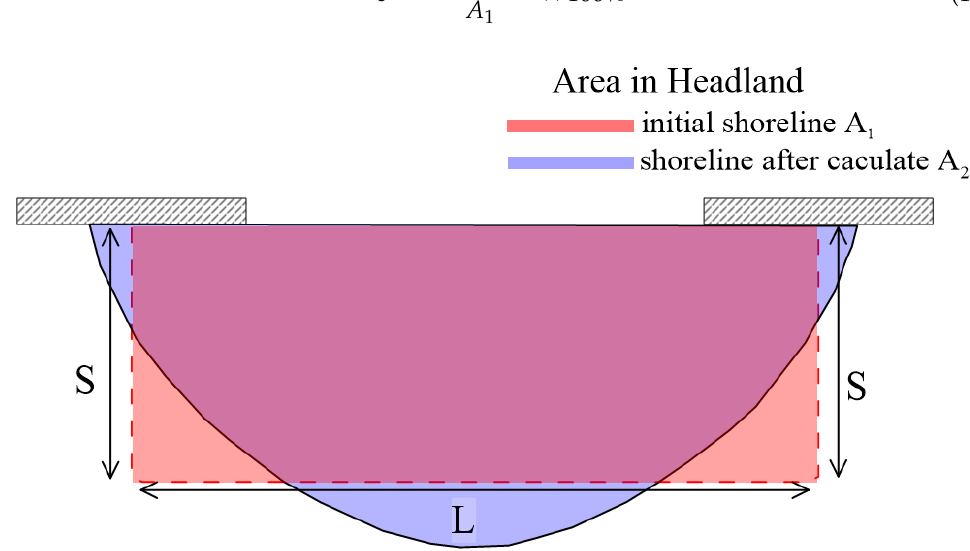
Figure 14. The definitions of two distinct areas, A 1 and A 2 , which are enclosed by shorelines and two headlands.